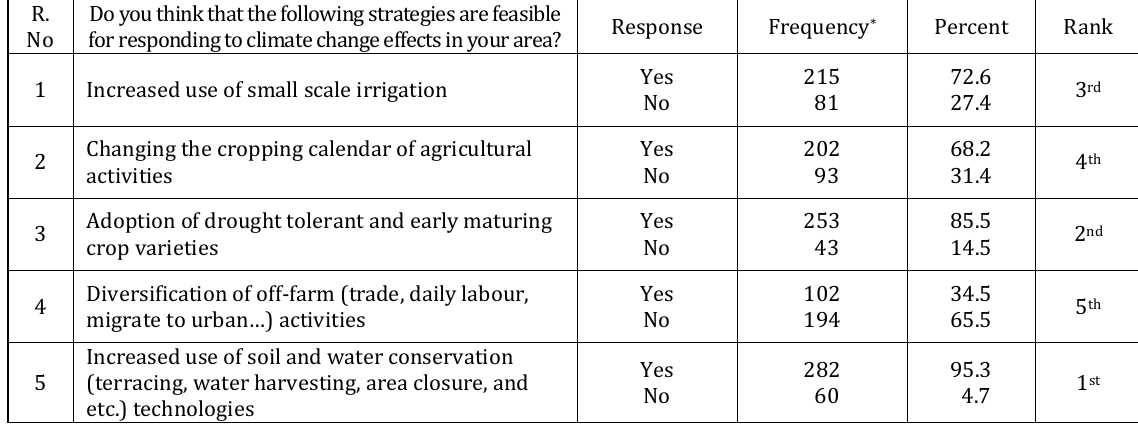
Table 7. Perceptions of respondent towards climate change adaptation strategies (Source: survey, April 2018)